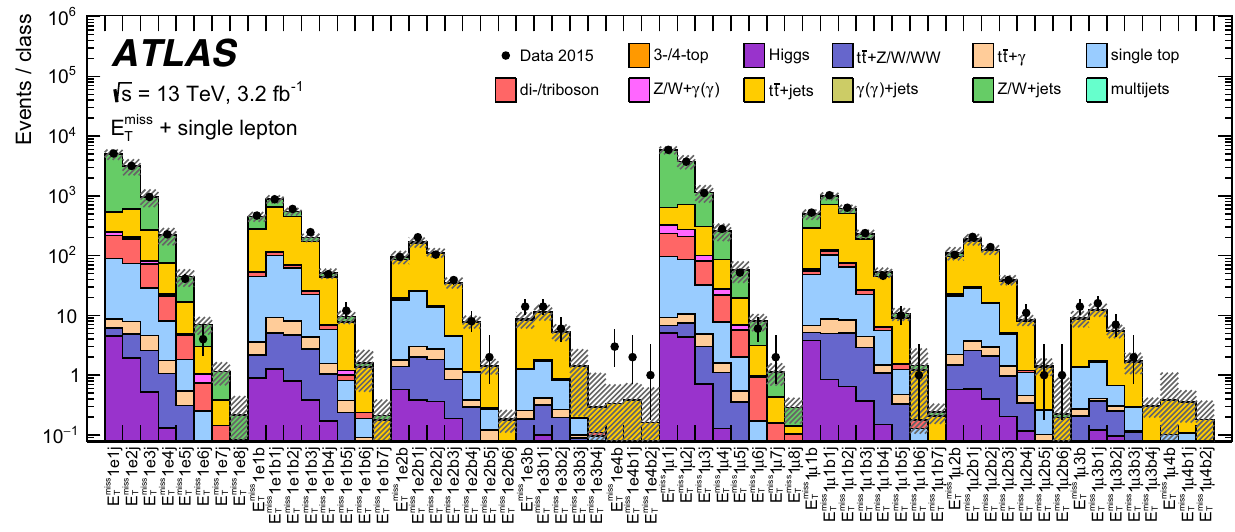
Fig. 3 The number of events in data, and for the different SM back- the given event class. The hatched bands indicate the total uncertainty ground predictions considered, for classes with large E miss , one lepton of the SM prediction. This figure shows 60 out of 704 event classes, the T and ( b -)jets (no photons). The classes are labelled according to the mul- remaining event classes can be found in Figs. 11, 12, 13, 14, 15, 16, 17, tiplicity and type ( e , μ , γ , j , b , E miss 18, 19, 20, 21, 22, 23 of Appendix ) of the reconstructed objects for T